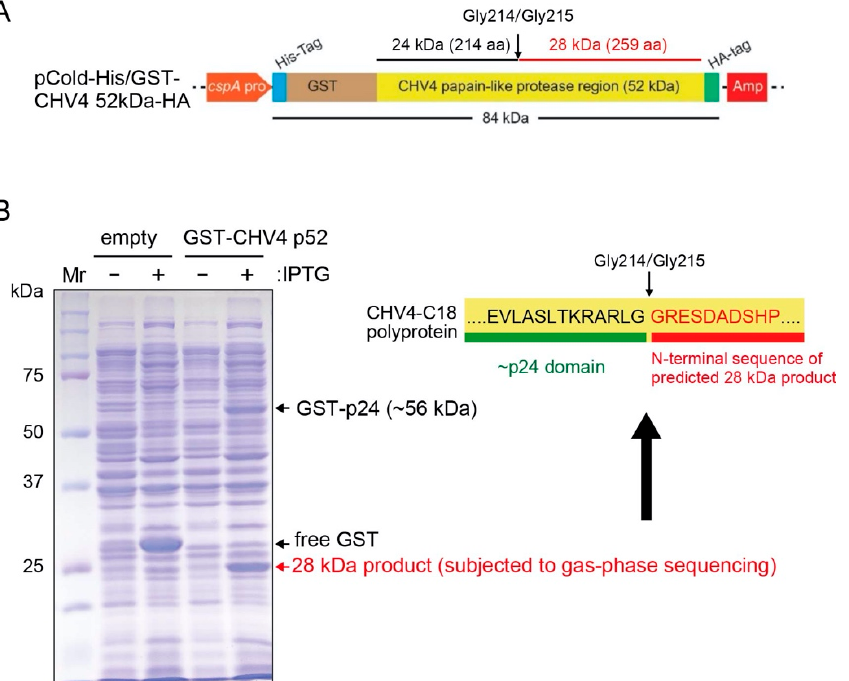
Figure 3. Autocatalytic proteolytic activity of CHV4 p24 encoded at the most N terminal portion of the viral polyprotein. ( A ) Schematic representation of the N terminal portion of the CHV4-C18 polyprotein. The N-terminal coding regions spanning amino acids 1 to 473 (the estimated molecular weight of ~ 52 kDa) was cloned into the Kpn I- Nde I site of an Escherichia coli expression vector, pCold. The 52kDa coding region was fused in frame with a His-tag and GST at the N-terminus and an HA-tag at the C-terminus (pCold-His/GST-CHV4 52kDa-HA, 86 kDa). The predicted cysteine and histidine residues and di-glycine are shown on the top. ( B ) The self-cleavage activity of CHV4-C18 p24 in the recombinant E. coli cells. Total proteins in E. coli cells transformed by the CHV4-52kDa expression construct and empty vector were electrophoresed in SDS-PAGE gel and stained with Coomassie Brilliant Blue. Two protein bands of 52kDa and 28 kDa were specifically induced in the recombinant cells with the CHV4-52kDa construct upon induction (left panel, shown with arrows). Unpurified fractions of the over-expressed protein encoded by the N terminal portion of CHV4 were blotted onto PVDF membrane, and the 28 kDa protein band was subjected to chemical sequencing. The six determined amino acid residues were the same as those deduced from the CHV4 nucleotide sequence. The cleavage site was experimentally identified as Gly245 ↓ Gly246, which had been predicted by Linder-Basso et al. [41].